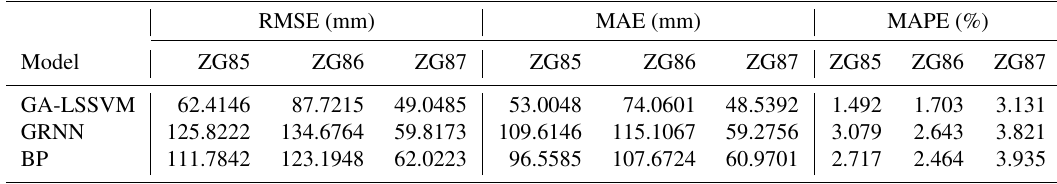
Table 6. Comparison of the performance of cumulative displacement prediction for the three models. RMSE (mm) MAE (mm) MAPE (%) Model ZG85 ZG86 ZG87 ZG85 ZG86 ZG87 ZG85 ZG86